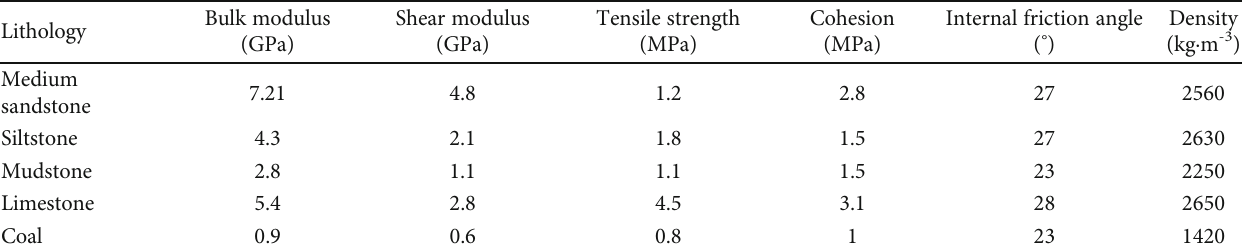
Table 2: Physical and mechanical parameters of